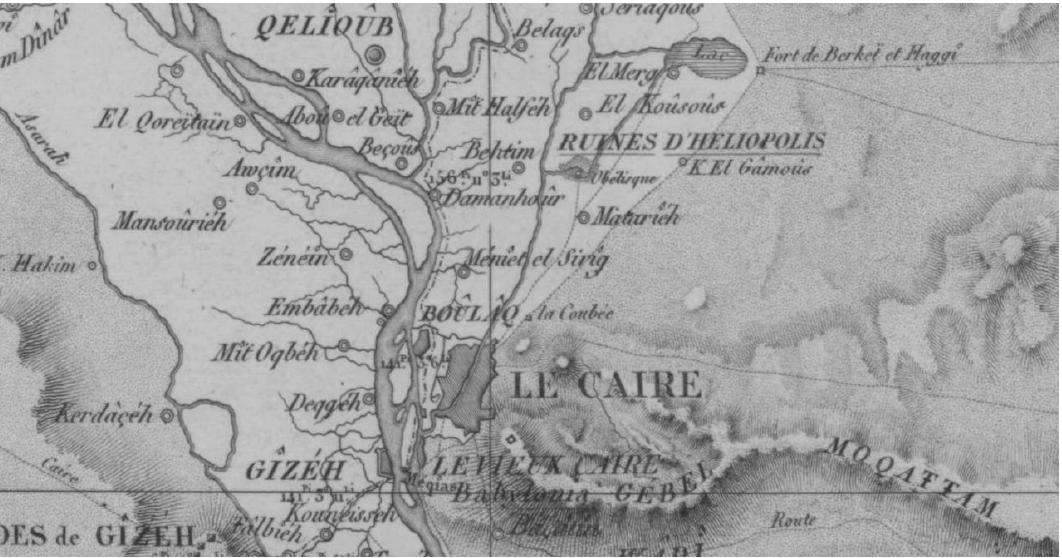
Figure 1: Canal passing through the center of Cairo heading northeast to Suez.